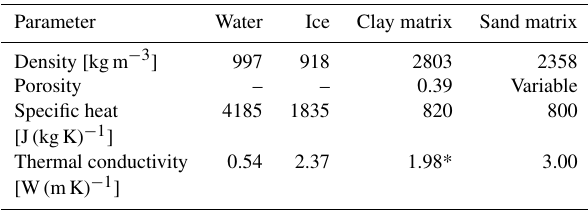
Table 1. Properties of the different components of the